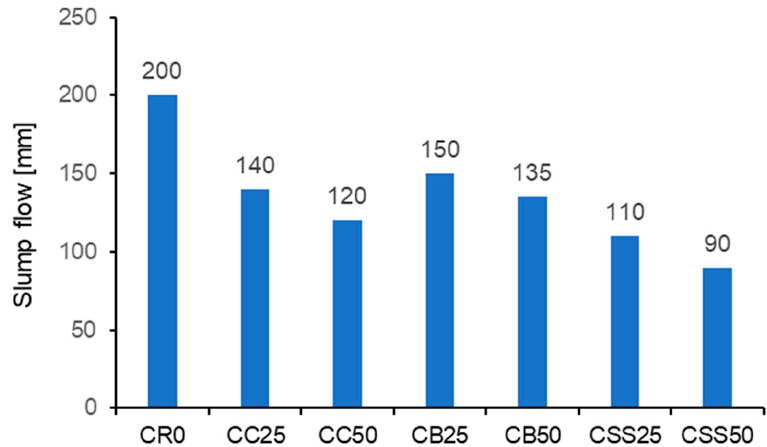
Figure 7. The results of the concrete mixes’ consistency testing.